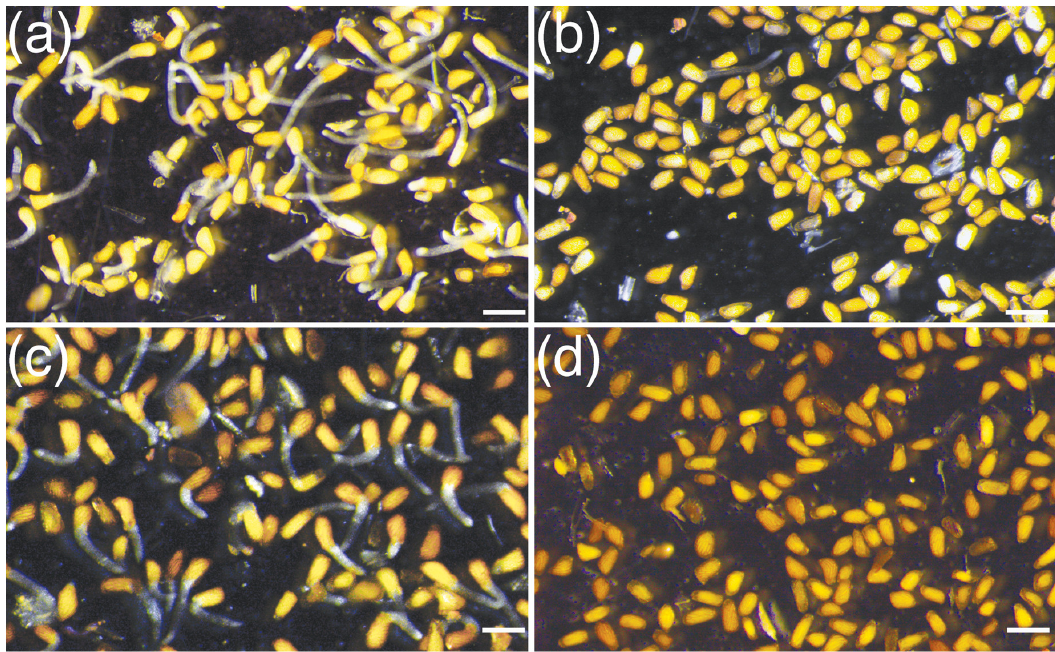
Figure 1. Crotalaria landraces displayed variation in their ability to stimulate Striga germination with regard to germination frequencies and radicle length of germinated parasite seedlings. ( a ) High induction of germination by C. brevidens landrace from Homabay County coded BHMBY0213. ( b ) Low induction of germination by C. ochroleuca , a landrace from Kisumu County coded MKSM0218 ( c ) Induction of germination by the synthetic strigolactone (GR24) – positive control and ( d ) Zero induction of germination by the negative control (water). Scale bar = 1 mm.